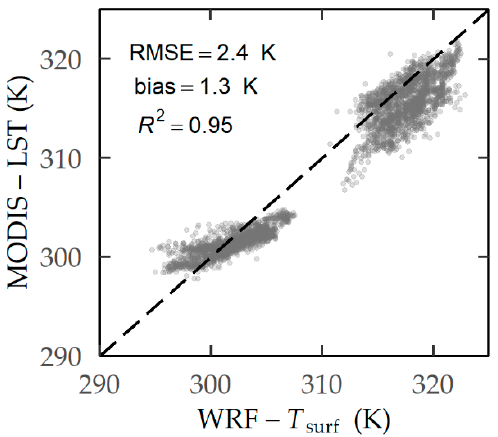
Figure 12. Comparison of the observed MODIS–LST (Aqua and Terra) and modeled surface temperature from WRF ( T s ) (average for the available imagery in 7–11 August 2017).